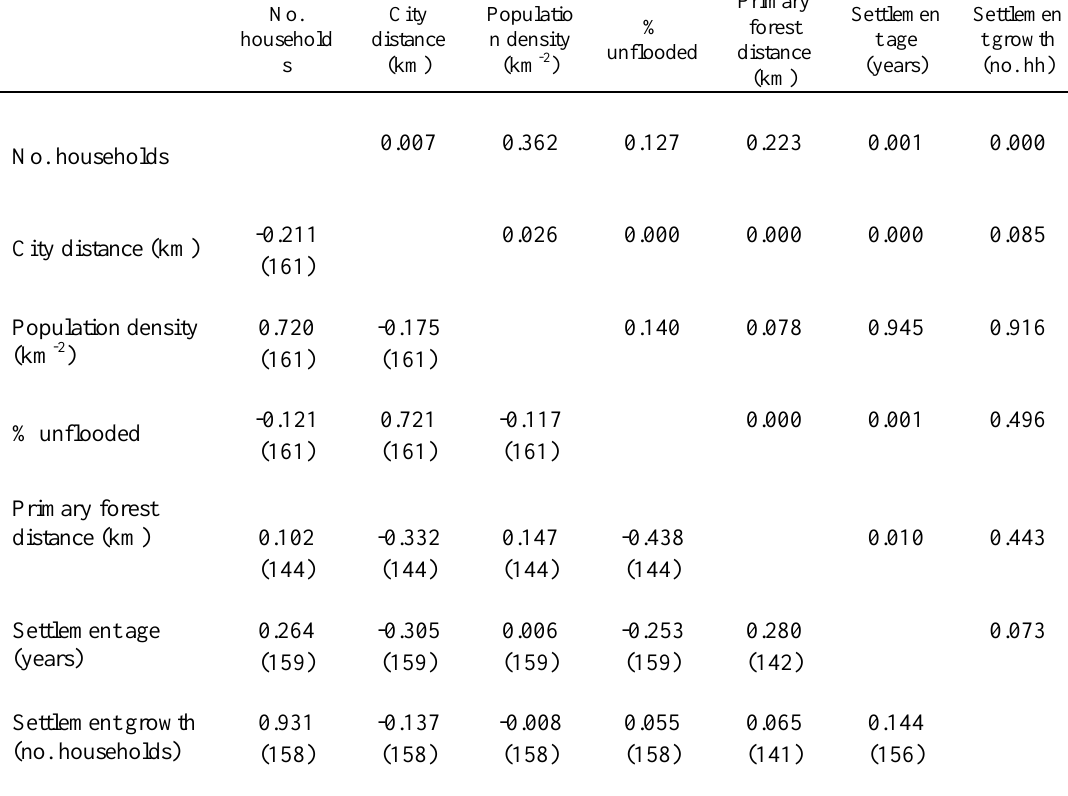
Table A2. Correlation matrix of settlement-scale predictors of depletion of hunted species, with correlation coefficients (r ) shown in bottom left, and P-values in top right. Sample s sizes are shown in parentheses beneath